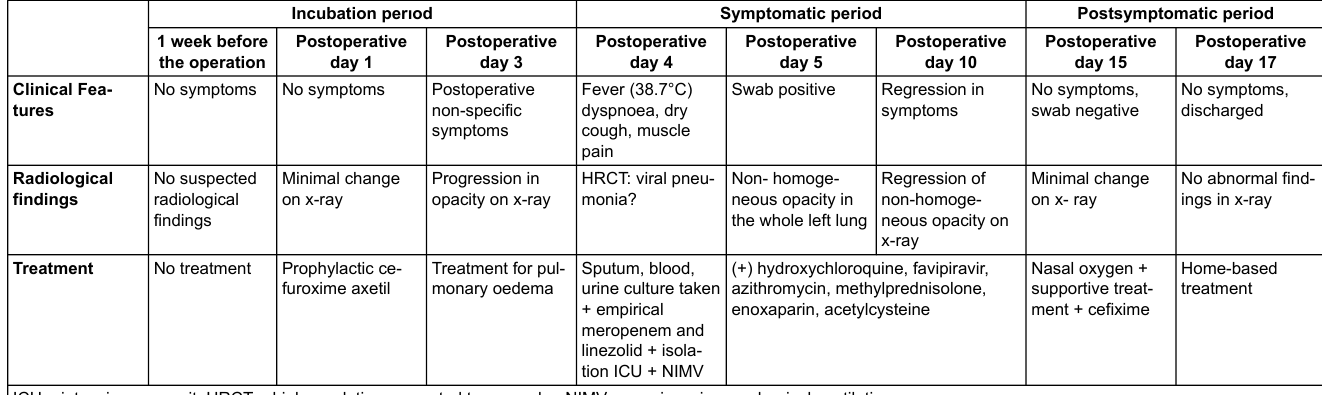
Table 1: Summary of the patient’s clinical features, radiological findings and treatment.